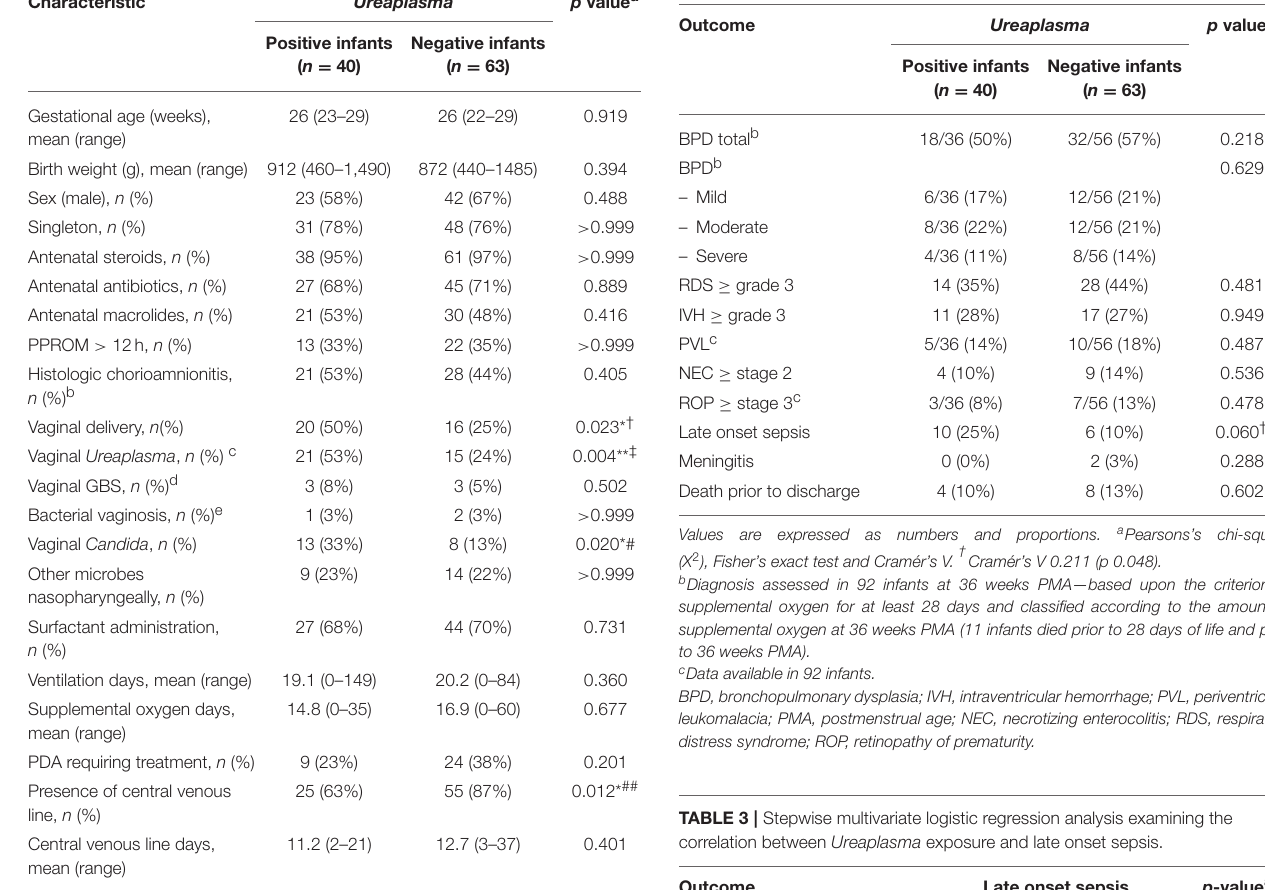
TABLE 2 | Bivariate analyses testing for associations between perinatal exposure to Ureaplasma and primary and secondary outcome measures. Outcome